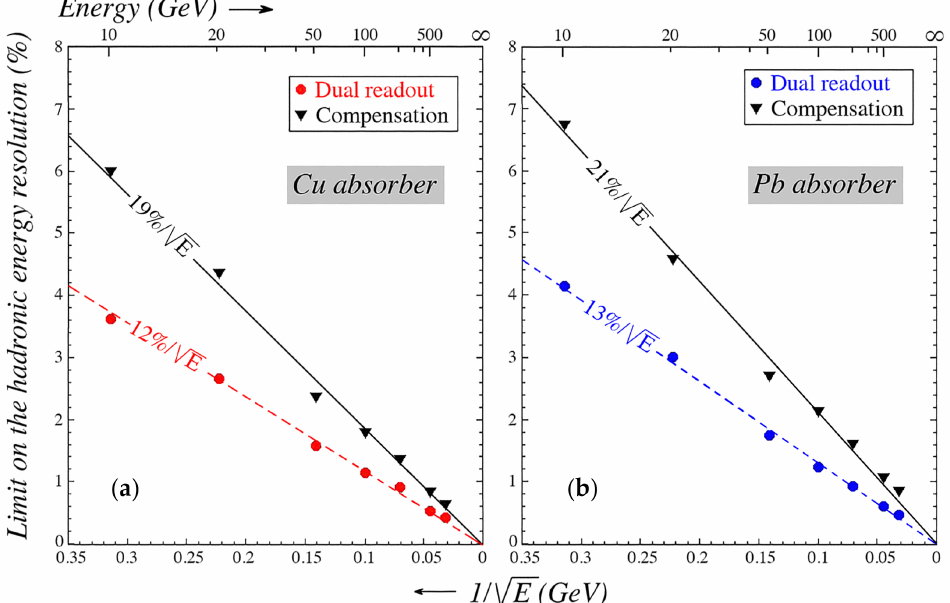
Figure 13. The limit on the hadronic energy resolution derived from the correlation between nuclear binding energy losses and the parameters measured in dual-readout or compensating calorimeters, as a function of the particle energy. Results from GEANT Monte Carlo simulations of pion showers developing in a massive block of copper ( a ) or lead ( b